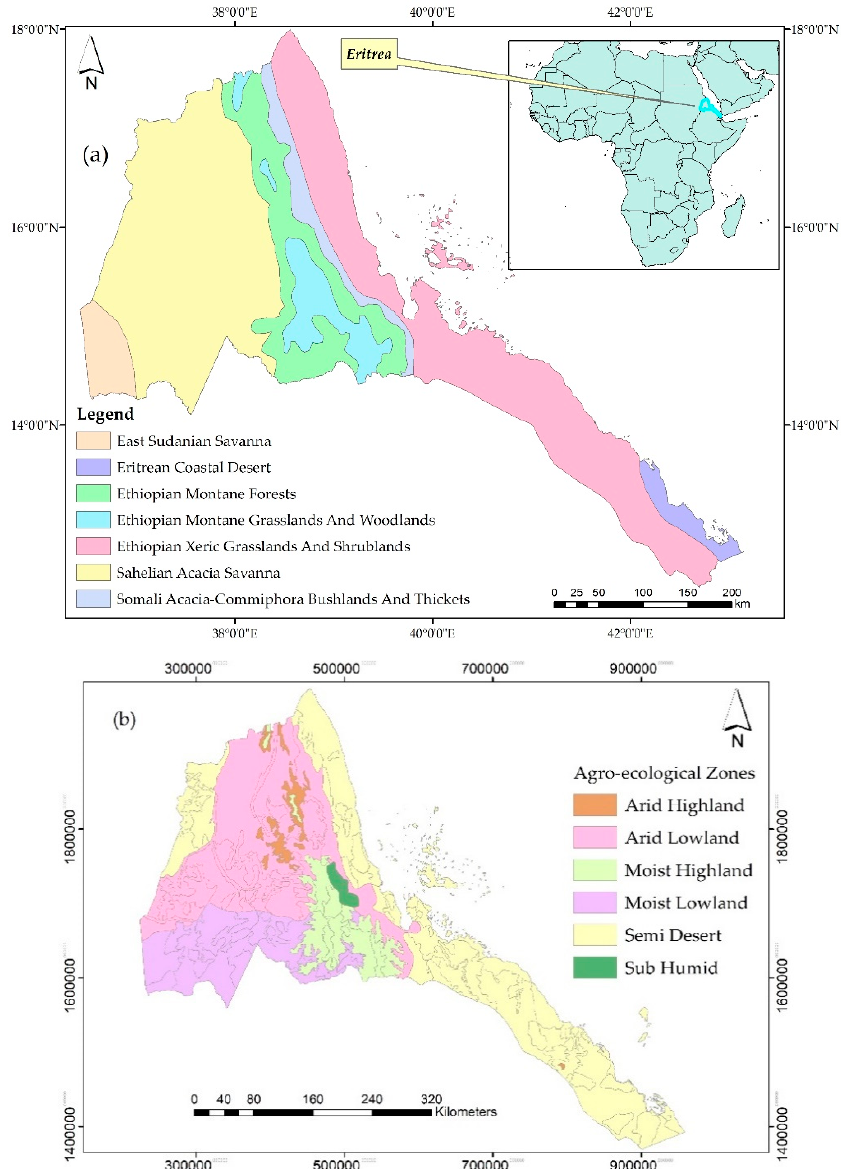
Figure 1. Eritrea and its eco-geographical regions. ( a ) The Nature Conservancy (2003), and Agro-ecological zones of Eritrea ( b ) Food and Agricultural Organization (1997).